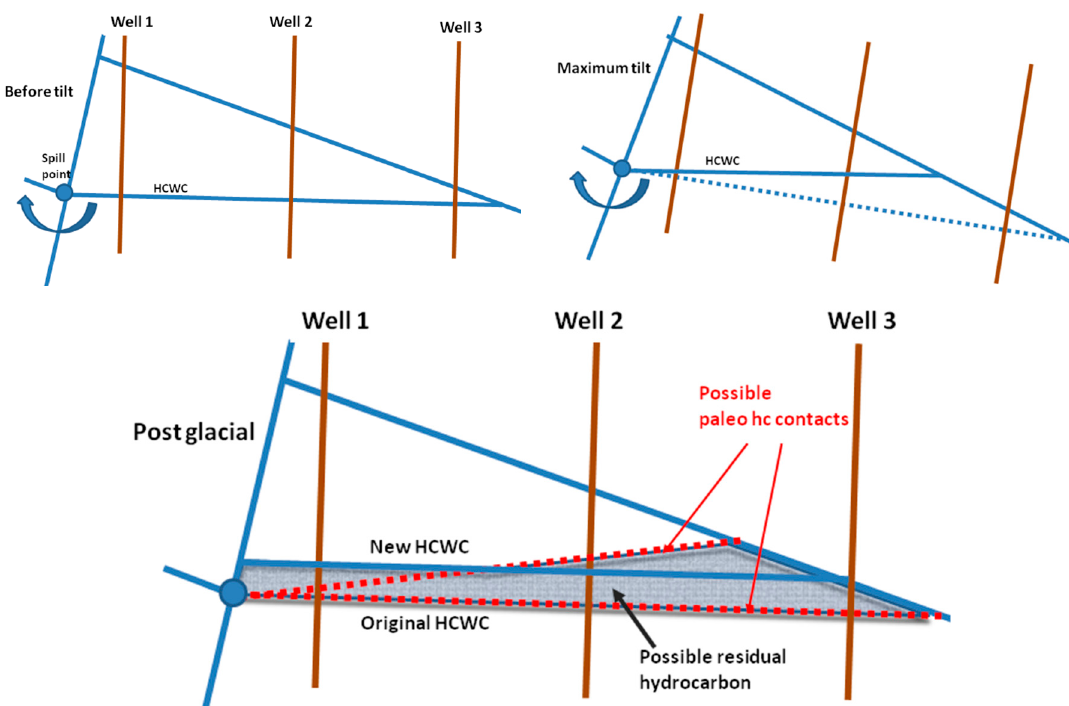
Figure 3. Illustration of tilting during one glacial cycle (redrawn from [5]). Upper left shows the situation prior to tilting; upper right during tilting. Lower panel shows the situation after deglaciation. “Spill point” is the structurally lowest point in a hydrocarbon trap that can retain hydrocarbons. Once a trap has been filled to its spill point, further storage or retention of hydrocarbons will not occur. The illustration assumes the trap filled to the spill point. HCWC is the hydrocarbon-water